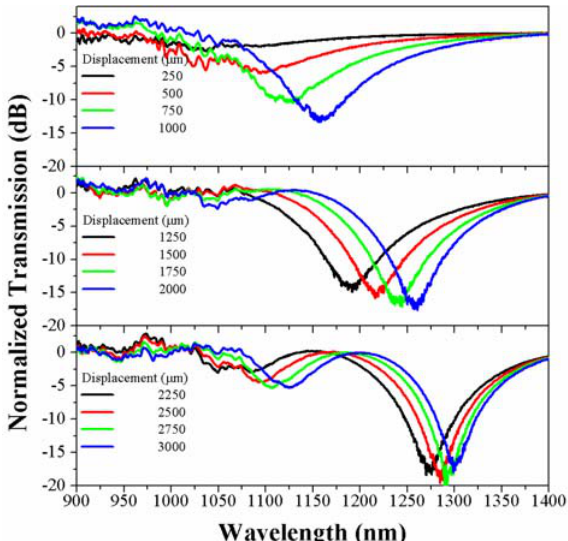
Figure 9. Spectral evolution of a loop displacement sensor made with a 3 mm transition length, 30 mm waist length, and 35 μ m waist diameter of taper, in a displacement range from 0–3